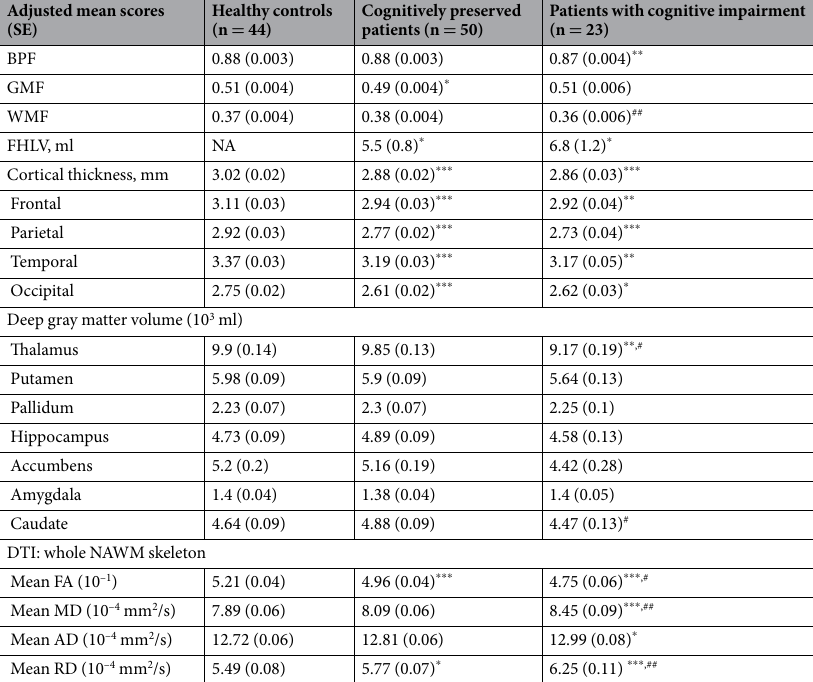
Table 4. MRI measures of healthy controls, the cognitively preserved and cognitively impaired patient groups. Abbreviations: BPF = brain parenchymal fraction; FHLV = FLAIR-hyperintense lesion volume; GMF = gray matter fraction; HCs = healthy controls; NA = not applicable; NMOSD = neuromyelitis optica spectrum disorder; SD = standard deviation; SE = standard error; WMF = white matter fraction. All comparisons were corrected for age. Post hoc analysis was performed using Bonferroni correction. * p < 0.05 compared to healthy controls. ** p < 0.01 compared to healthy controls. *** p < 0.001 compared to healthy controls. # p < 0.05 compared to cognitively preserved patients. ## p < 0.01 compared to cognitively preserved